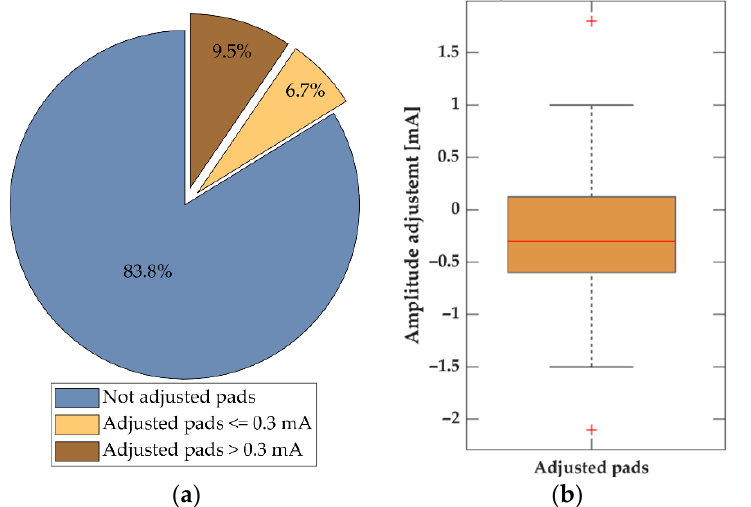
Figure 6. Manual adjustment of the automatically estimated localization amplitudes during the calibration process. ( a ) Pie chart indicating the percentage of pads not adjusted (blue), the percentage of pads with the amplitude adjusted, where the adjustment (absolute value) was less or equal to 0.3 mA (beige), and the percentage of pads with absolute adjustment greater than 0.3 mA (brown). ( b ) Boxplot of the difference between the automatically and manually adjusted pads amplitudes in cases when the amplitude was adjusted (16.2% of all pads).